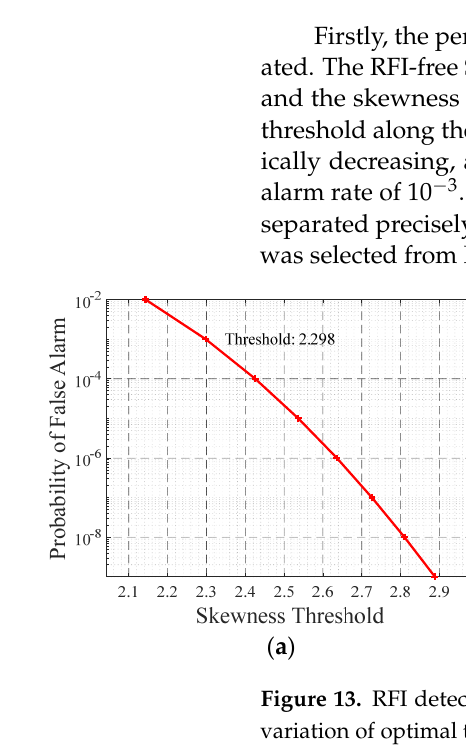
Figure 12. SAR image of the measured data ( a ) without RFI and ( b ) corrupted with simulated RFI.